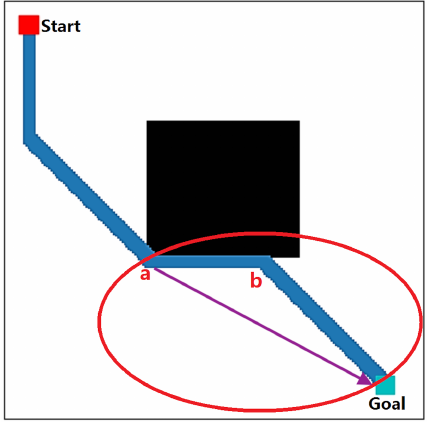
Figure 4. Path planned by D*